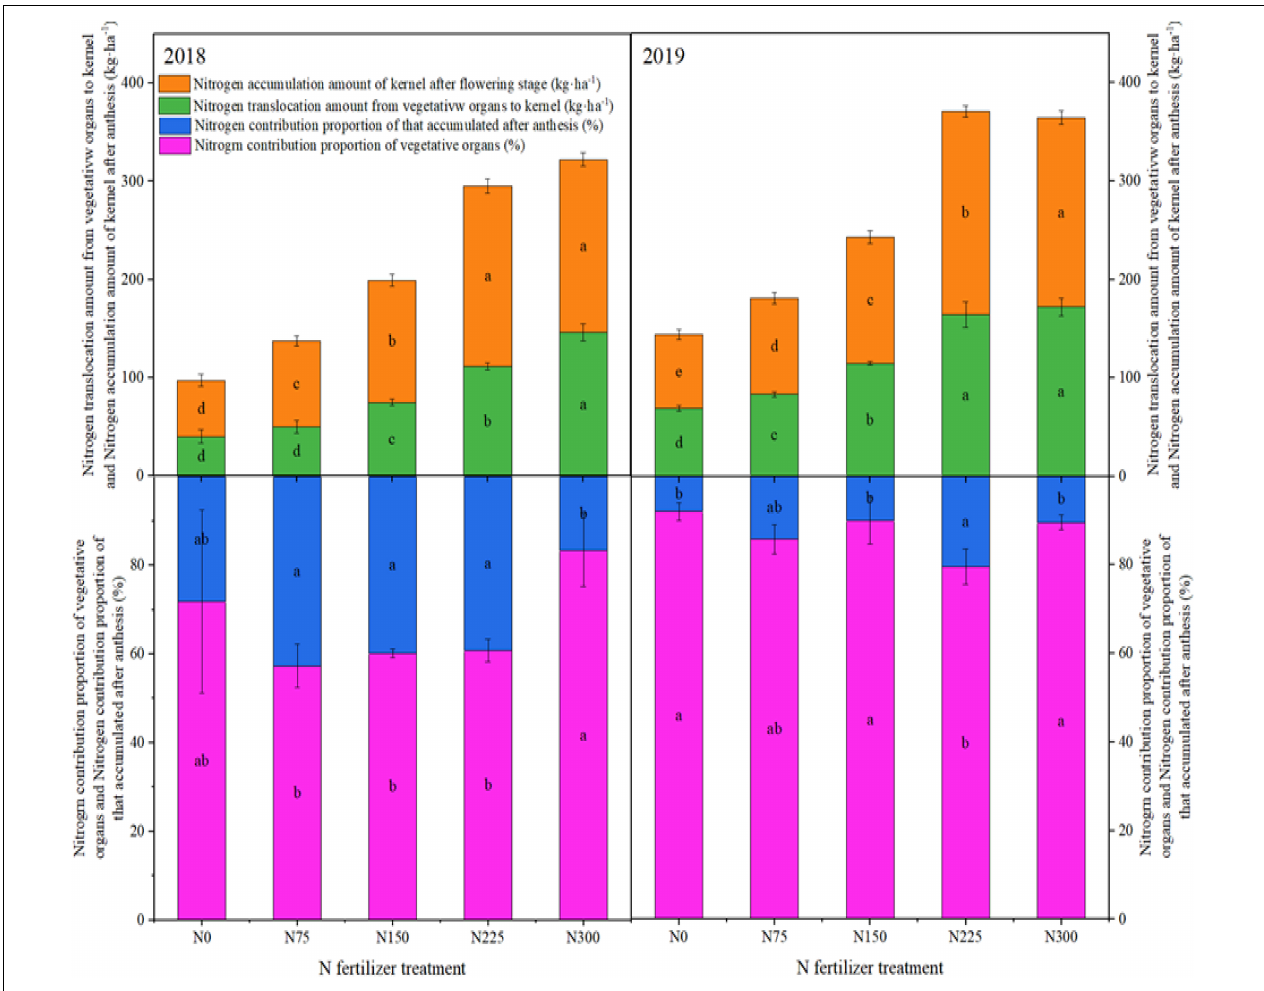
FIGURE 5 | Influence of different nitrogen (N) application rates on N accumulation amount of kernel after flowering stage, N translocation amount from vegetative organs to the kernel, N contribution proportion of that accumulated after anthesis stage and N contribution proportion from vegetative organs in winter wheat during 2018 and 2019. In bars of specific colors, different small letters show significant differences among N treatments. N0: unfertilized control; N75: N application at 75 kg N · ha – 1 ; N150: N application at 150 kg N · ha – 1 ; N225: N application at 225 kg N · ha – 1 ; N300: traditional N application rate of 300 kg N · ha – 1